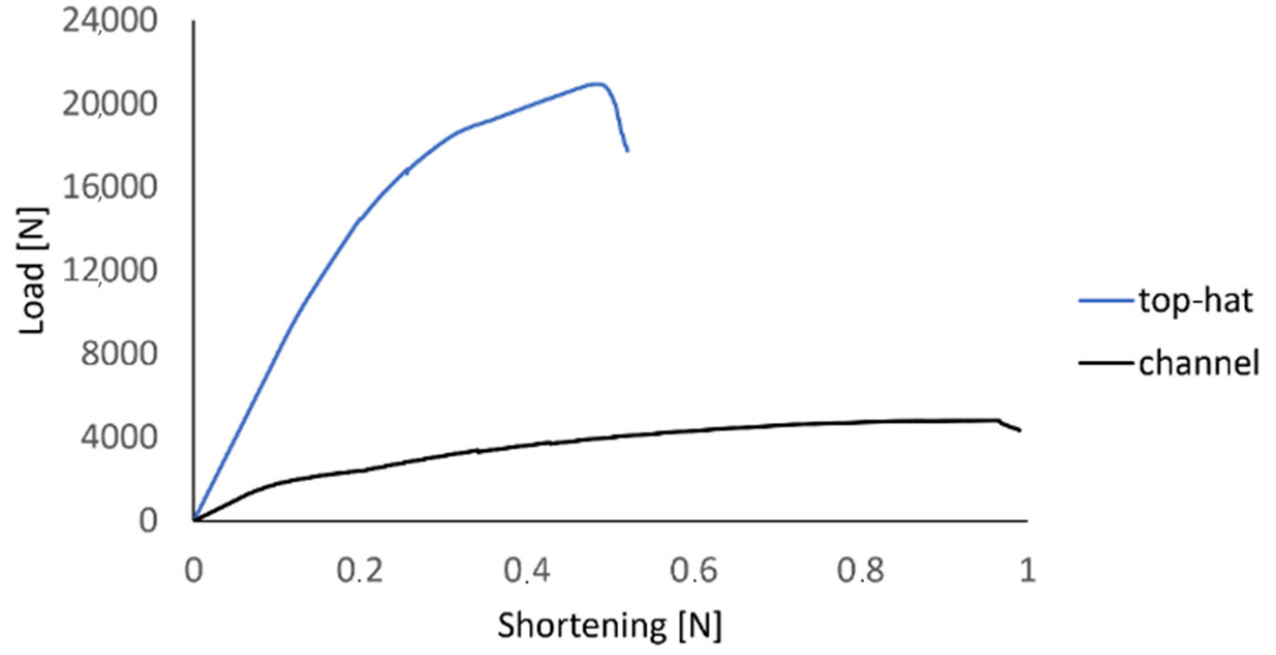
Figure 8. Failure characteristics—results of numerical simulations.